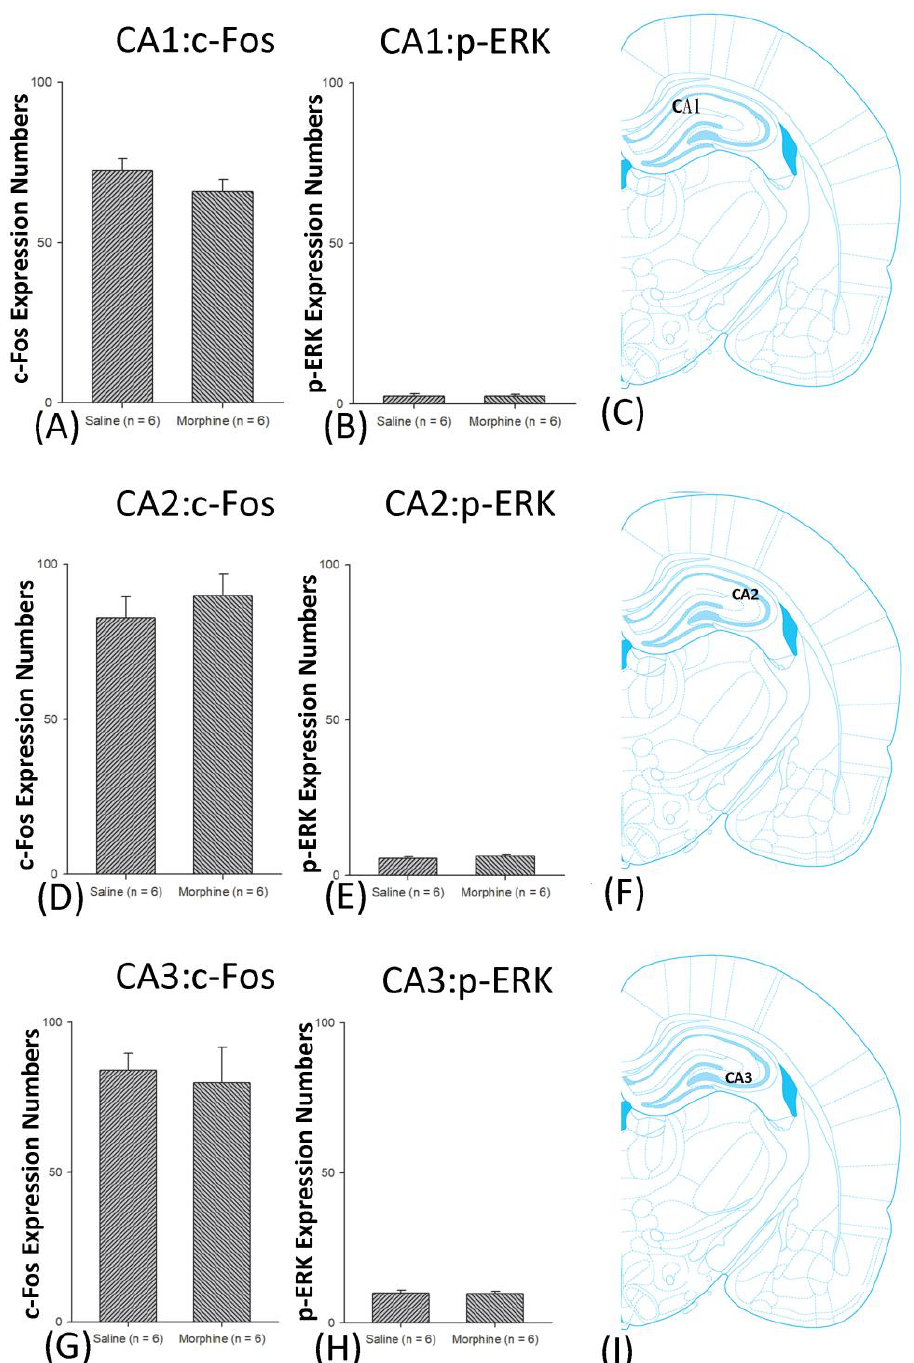
Figure 16. c-Fos or p-ERK immunoreactivity in the CA1, CA2, and CA3 in conditioning. ( A ) c-Fos expression and ( B ) p-ERK expression in the CA1, ( D ) c-Fos and ( E ) p-ERK expression in the CA2, and ( G ) c-Fos and ( H ) p-ERK expression in the CA3 for reinstatement. ( C , F , I ) indicate a schematic representation of the CA1, CA2, and CA3. * p < 0.05 when comparing the saline and morphine groups ( n = 6 per group).